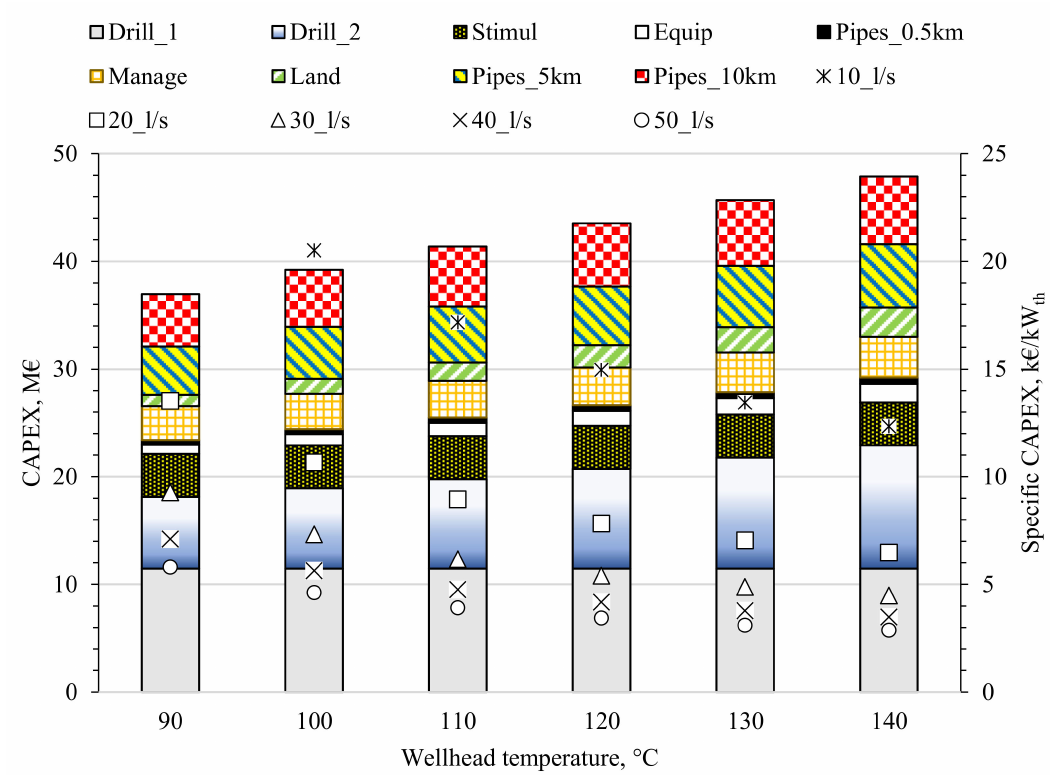
Figure 4. Components of CAPEX for different wellhead temperatures and different distances to the campus under the reference case conditions (columns) and specific CAPEX for different flow rates under the reference case conditions (symbols). Note: the value of specific CAPEX for 10 l/s under 90 ◦ C is 26.1 k € /kW th .